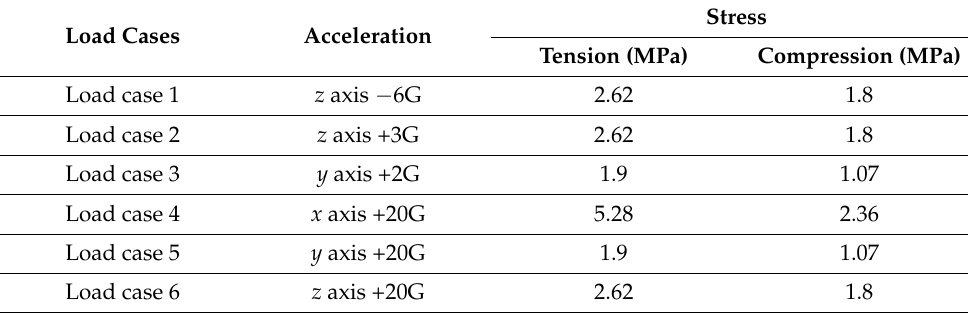
Table 2. Structural analysis results of s-duct structure.